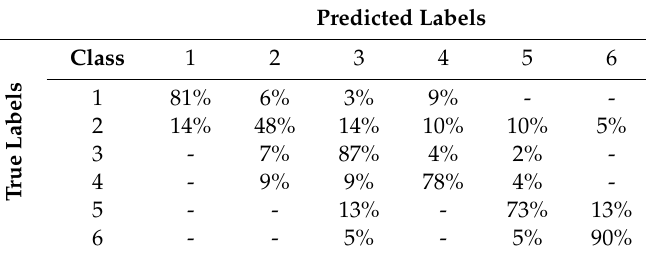
Table 5. Confusion matrix for the model of occurrence (M O ).